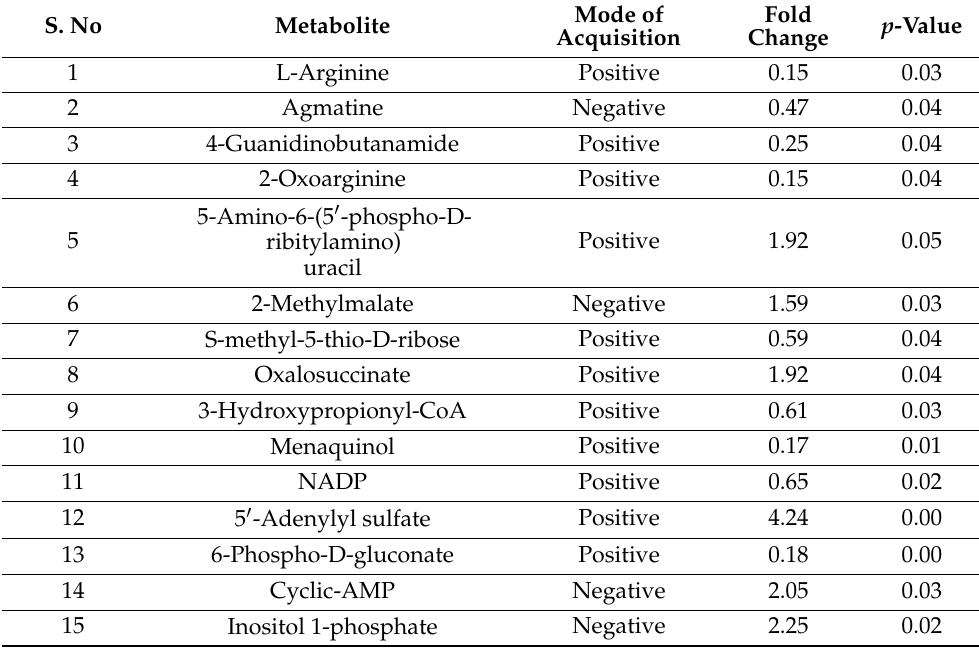
Figure 2. Data visualization plots. PCA clustering of PRK-treated and untreated Mtb H37Rv samples in ( A ) positive mode and ( B ) negative mode. Volcano plots showing the distribution of identified features in ( C ) positive mode and ( D ) negative mode. The differentially expressed metabolites with p -value ≤ 0.05 are highlighted in blue and red in the respective plots. Table 1. A partial list of differentially expressed